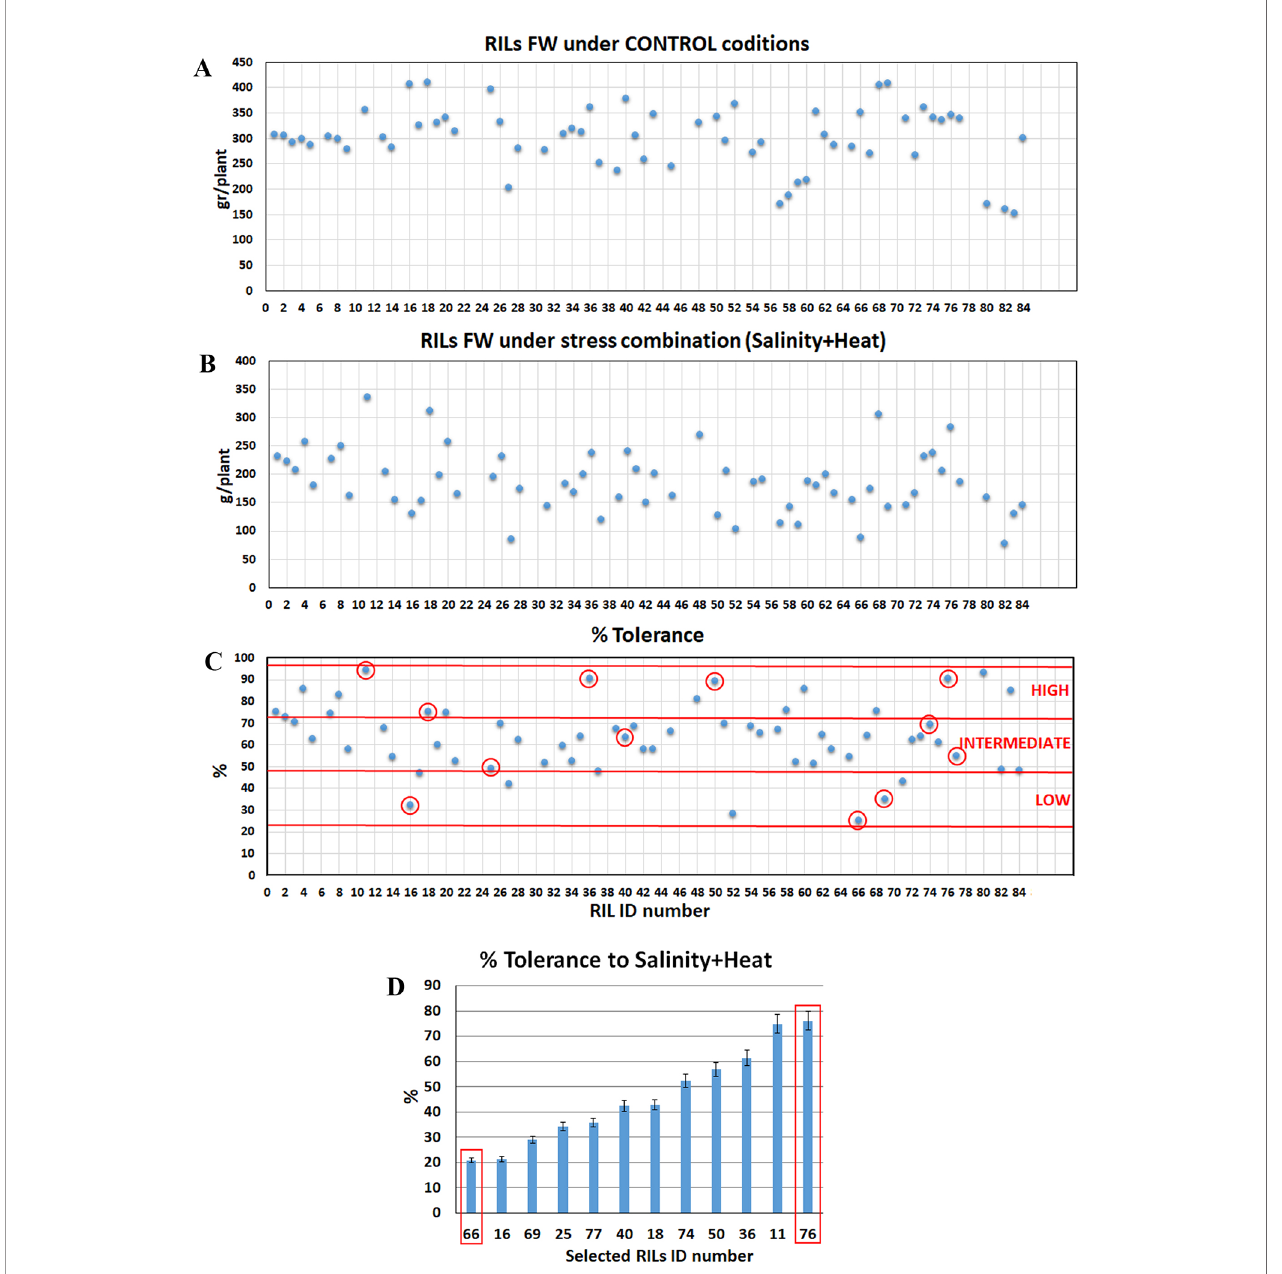
FIGURE 1 | Tomato recombinant inbred lines (RILs) selection for their tolerance to the combination of salinity and heat. Eighty four RILs lines were grown under control (A) and under the combination of salinity and heat (B) and fresh weight (FW) was recorded. Twelve RILs were selected for each grade of tolerance (low, intermediate, and high tolerance) to the combination of salinity and heat as compared to control plants (C) . The selected lines (C, red circle) were grown again under growth chamber conditions to validate the different grade of tolerance obtained previously under greenhouse conditions. RIL-66 (low tolerant) and RIL-76 (high tolerant) were selected for further experiments (D) . Values represented in each fi gure are means ± SE (n =